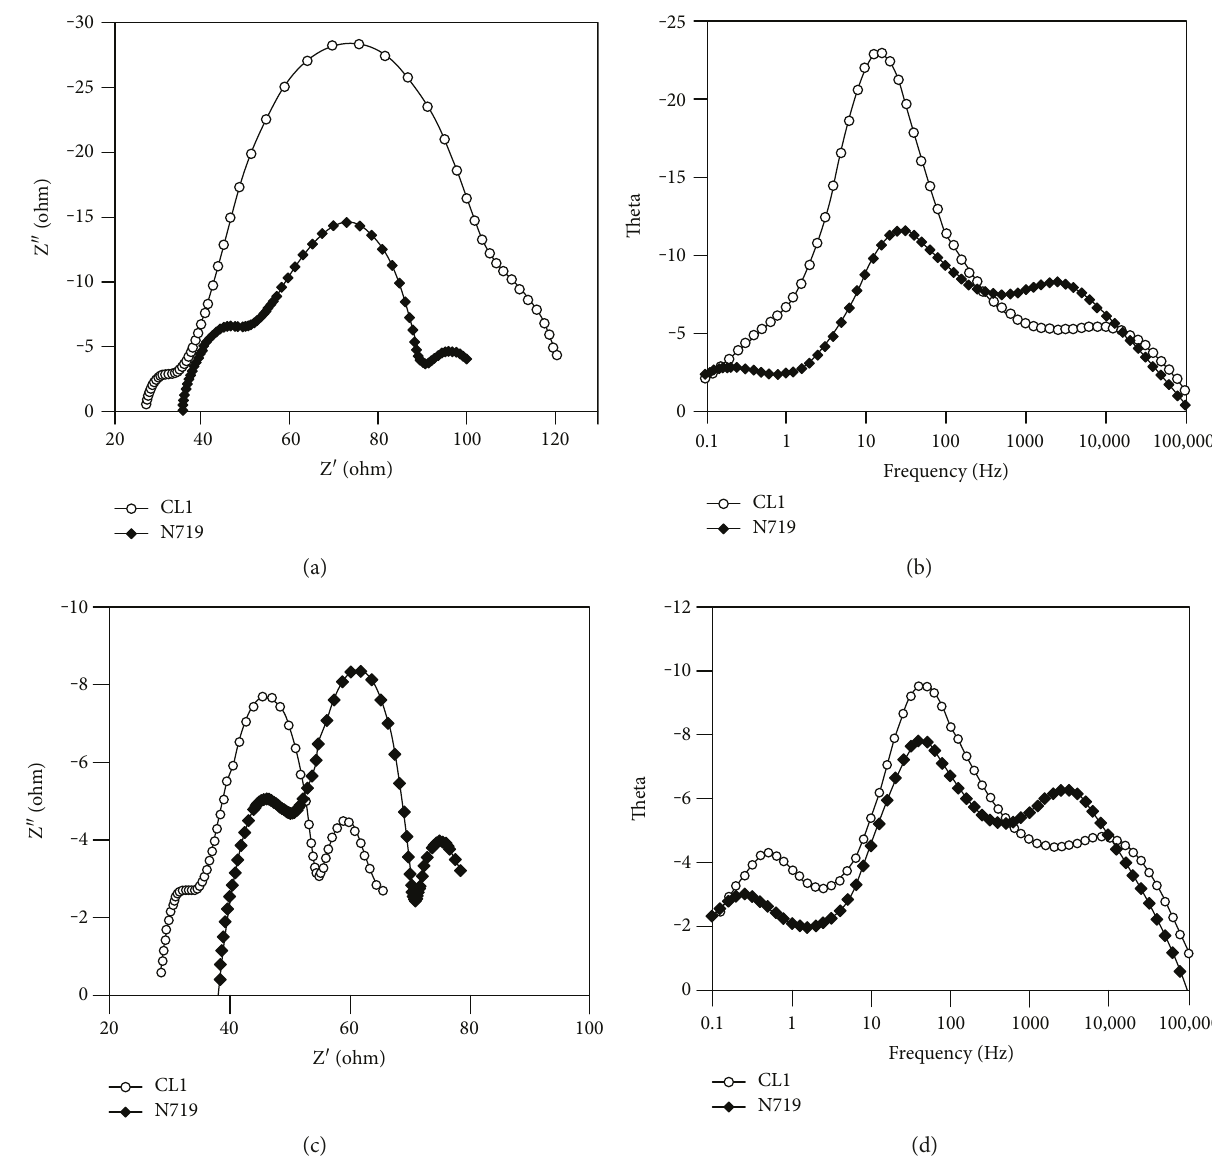
Figure 5: Nyquist ((a) and (c)) and Bode phase ((b) and (d)) plots of N719 and CL1 dye sensitised DSSCs in the dark ((a) and (b)) at − 0.67V and under 1 sun illumination ((c) and (d)) at open-circuit voltages.